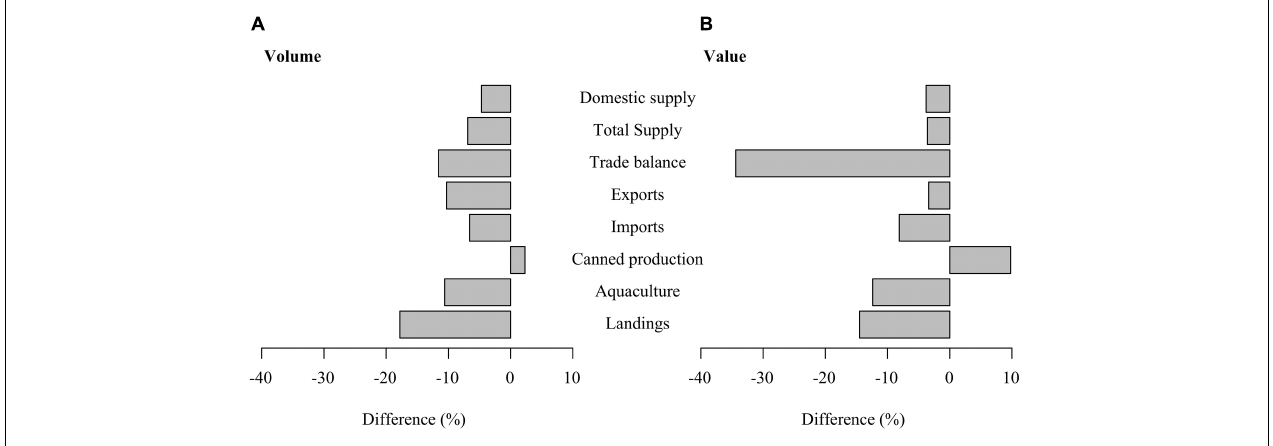
FIGURE 5 | Impact of COVID-19 on the Galician seafood sector in (A) volume and (B) value, the difference (in %) between 2015 and 2019 vs. 2020 is shown.